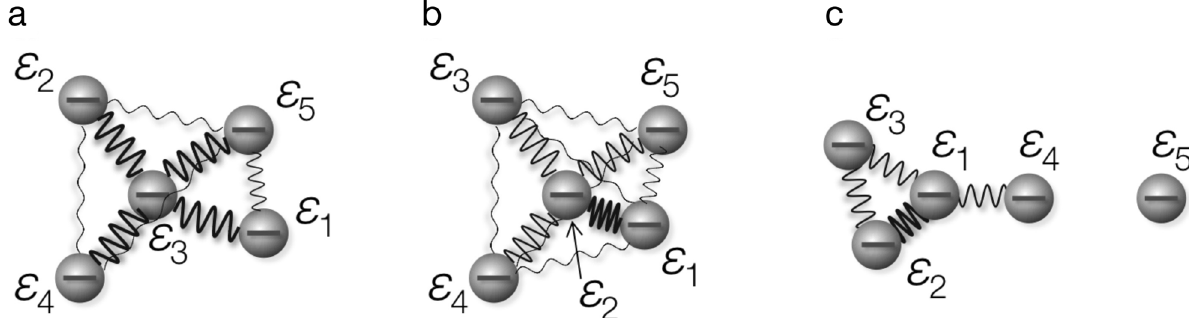
Fig. 10 Graphical representations of the optimal con fi gurations. Panels a – c correspond to concrete examples of realizations of the Pareto-optimal interacting machines identi fi ed in Fig. 2a – c, where ϵ l is a (nondegenerate) single-electron energy of l th level considered in Fig. 2. A wave line between quantum dots indicates the presence of interaction between them. The width of the wave line shows the interaction